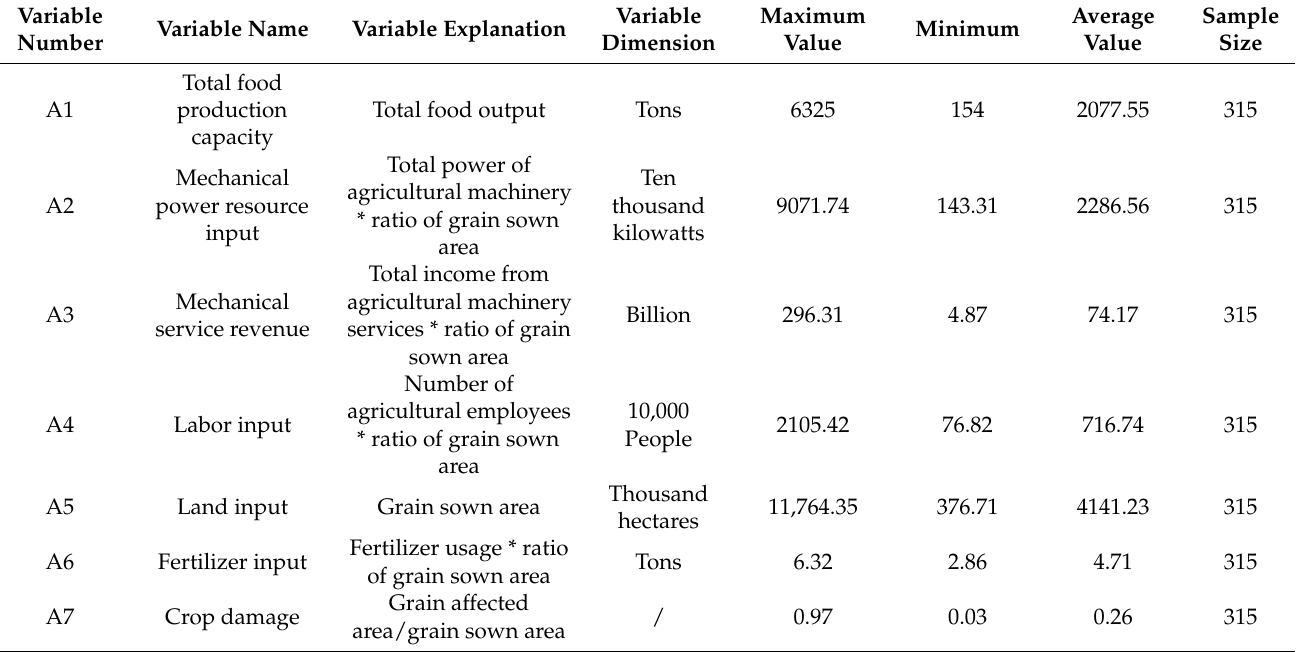
Table 1. Provincial panel data variables.